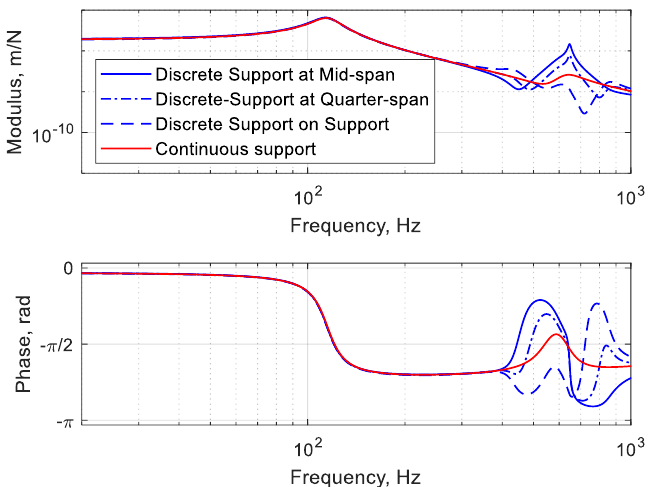
Figure 6. Analytical direct receptance calculated with discretely and continuously supported track. When discrete supports are considered, the receptance is calculated at different positions along the span between two supports.